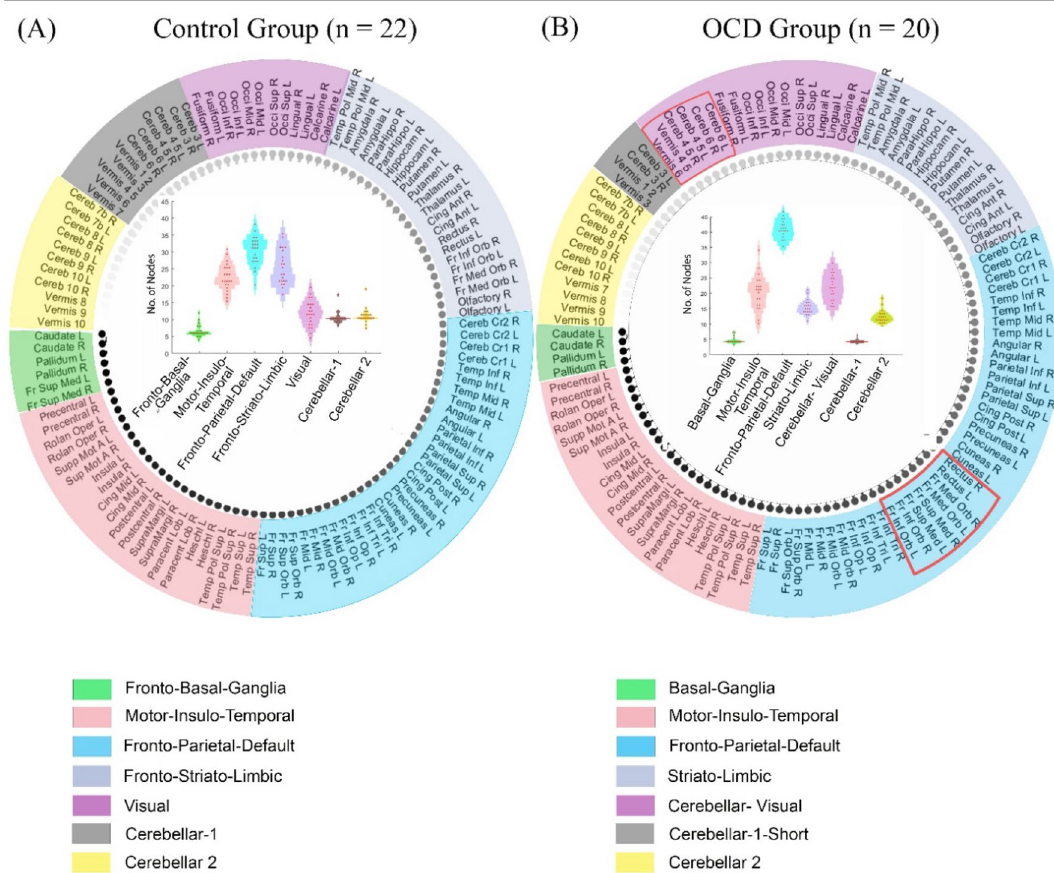
Figure 2. Communities in each control and patient group. The outer circle shows the median of the number of nodes (in a community) across the subjects and brain areas involved in each community. The communities (colored regions) are named based on the areas they encompass. Inside the inner circle, the inter-individual variation (red dots inside the violin plots, where one red dot = one participant) in the number of nodes in each community can be visualized for the control group. Seven communities were delineated for the ( A ) controls, and ( B ) patients with OCD. We also highlight that the frontal and cerebellar areas were observed only in the OCD group but not control group (enclosed in red boundaries). The abbreviations of brain areas were labelled according to the AAL atlas (please refer to the supplement for a full expansion of the